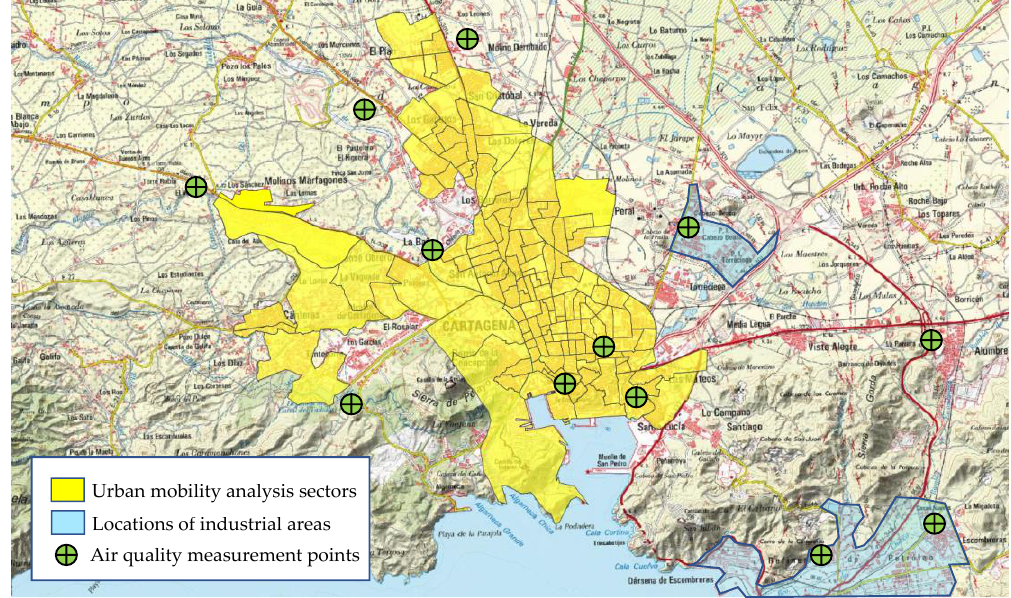
Figure 1. Air quality measurement points and division of the city of Cartagena into sectors for anal- ysis.